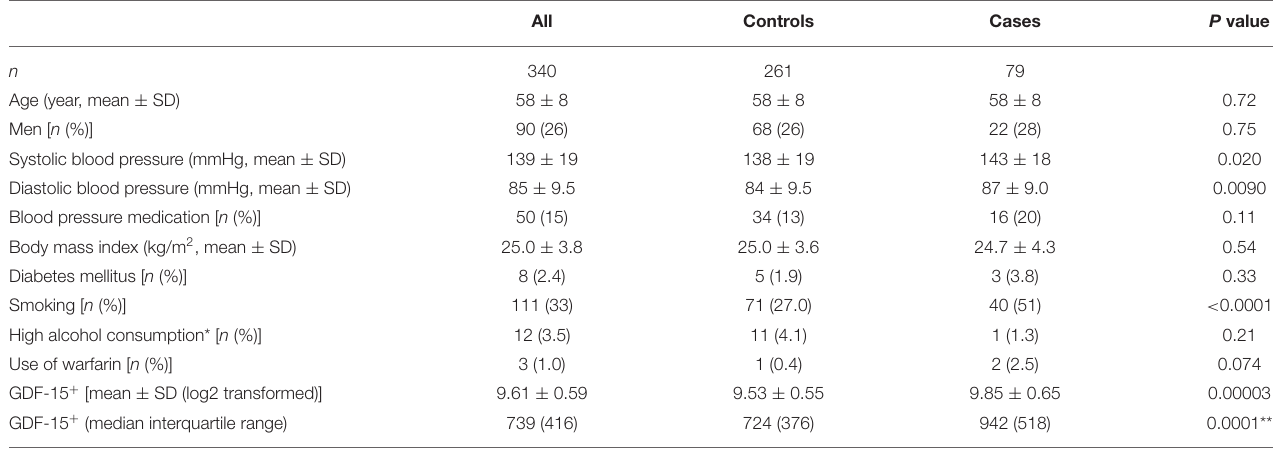
TABLE 2 | Baseline characteristics including levels of GDF-15 in SAH cases and controls. All Controls Cases P